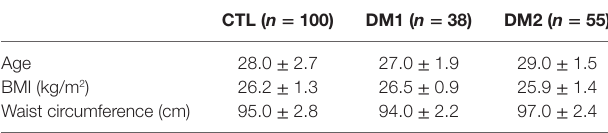
Table 1 | Anthropometric parameters of patients with type 1 diabetes mellitus (DM1), type 2 diabetes mellitus (DM2), and the control (CTL)